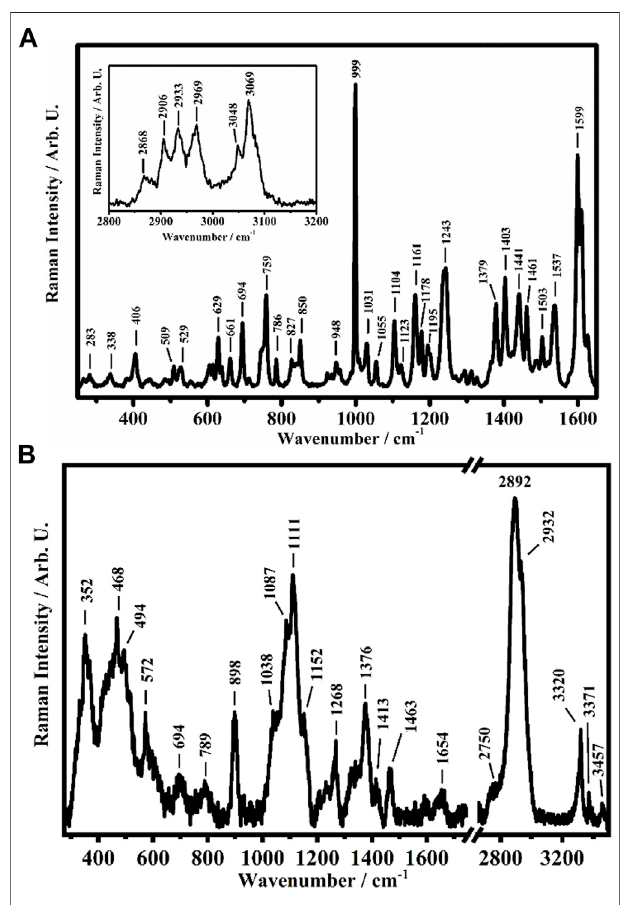
FIGURE 2 | Representative Raman spectra collected on (A) the [Zn(Q PhtBu ) 2 (MeOH) 2 ] complex in the solid crystalline phase in the ranges between250 cm − 1 and 1,650 cm − 1 and between 2800 cm − 1 and 3200 cm − 1 (in the inset) and (B) on CS in the ranges between 275 cm − 1 and 1750 cm − 1 and between 2650 cm − 1 and 3500 cm − 1